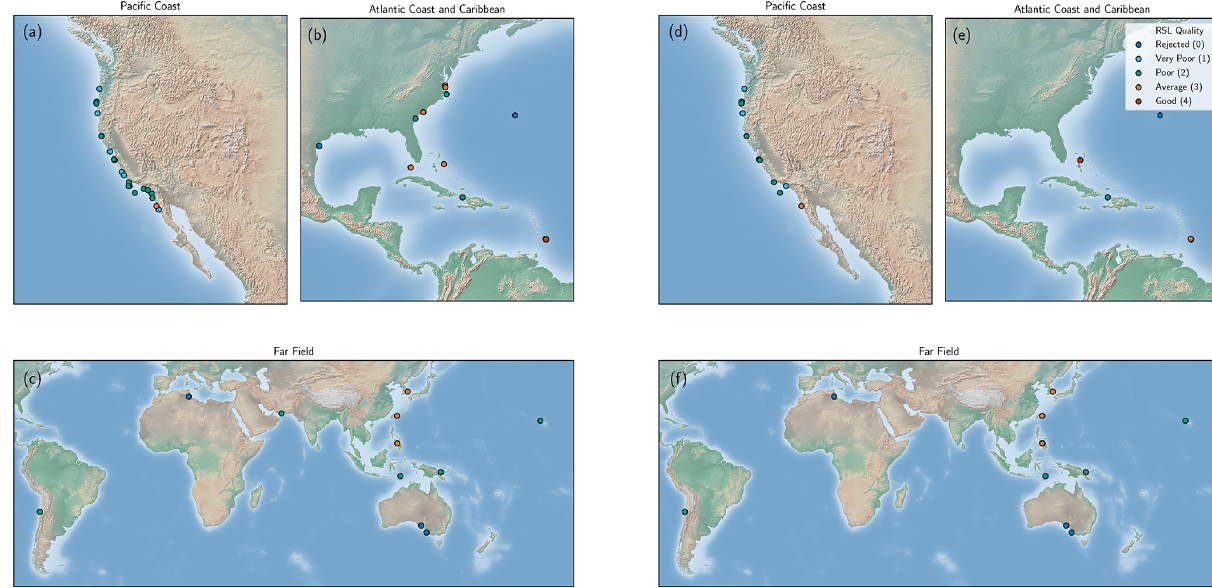
Figure 6. MIS 5a (a–c) and MIS 5c (d–f) sea level indicator elevation quality ratings atop the Matplotlib Basemap Shaded Relief map (Hunter, 2007). For the five Iranian subsites we plotted the lowest quality ratings of those listed in Tables 1 and